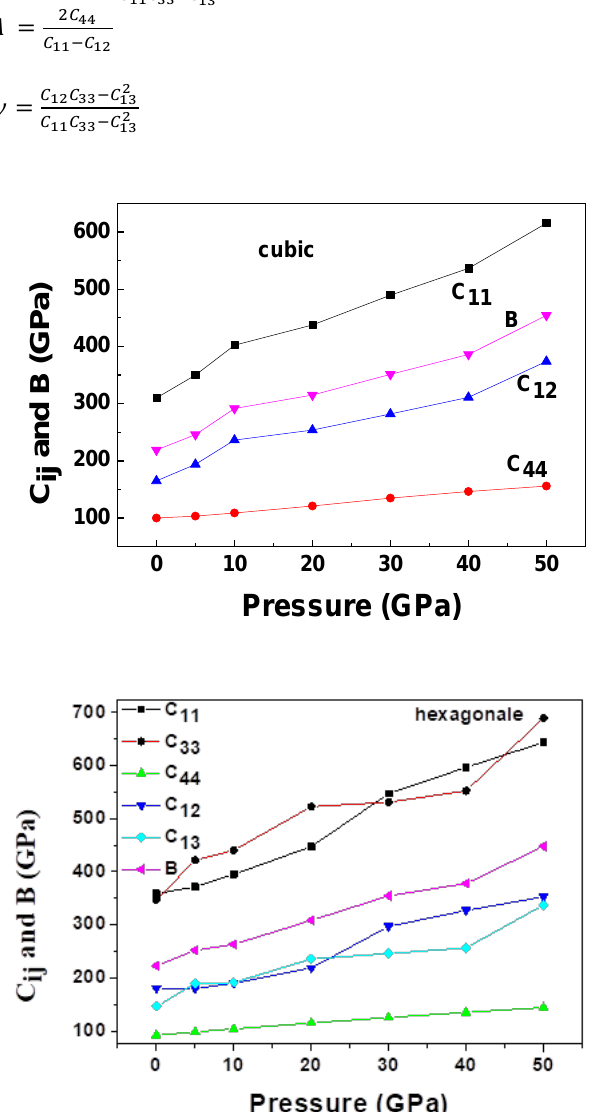
Fig. 5. The elastic constants of the cubic and hexagonal structures of Fe 2 Hf compound under pressure up to 50 GPa at 0